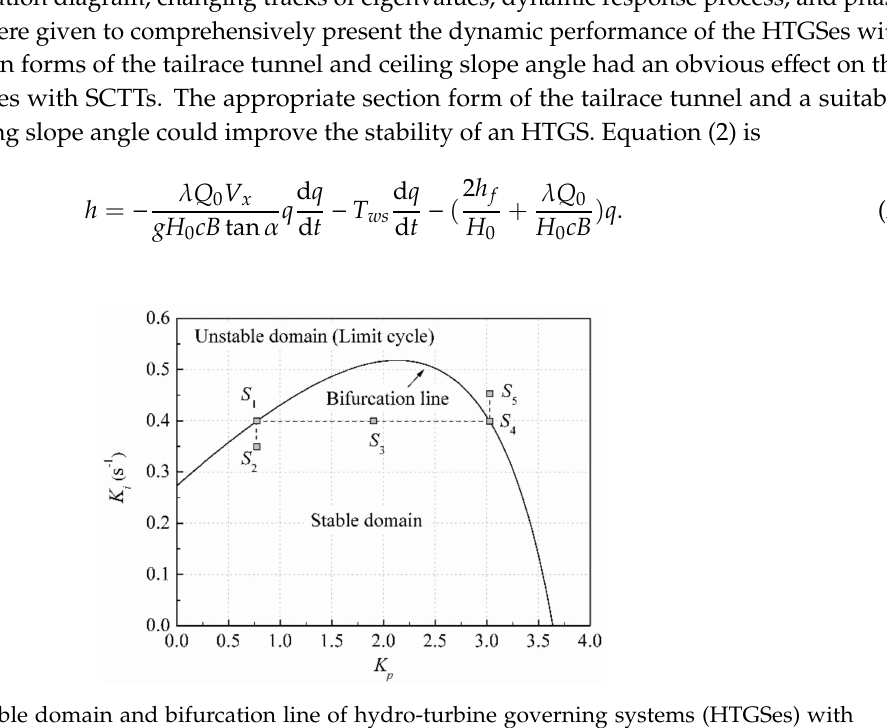
Figure 22. Stable domain and bifurcation line of hydro-turbine governing systems (HTGSes) with SCTTs. Reproduced with permission from [39], Elsevier, 2015.